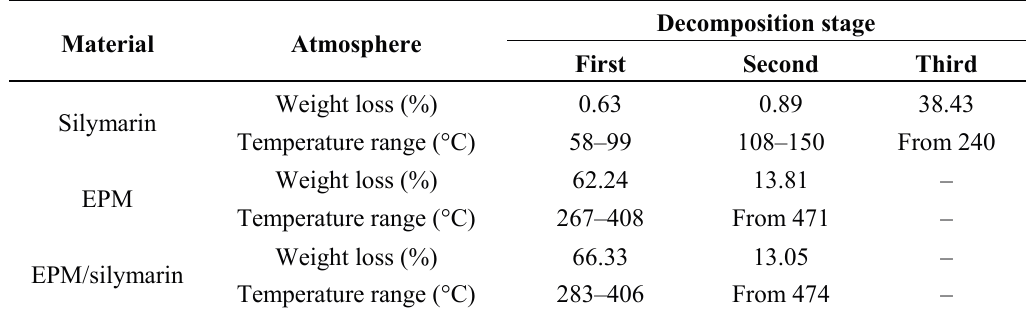
Table 1. Thermogravimetric characteristics of silymarin and EPM copolymer stabilized with